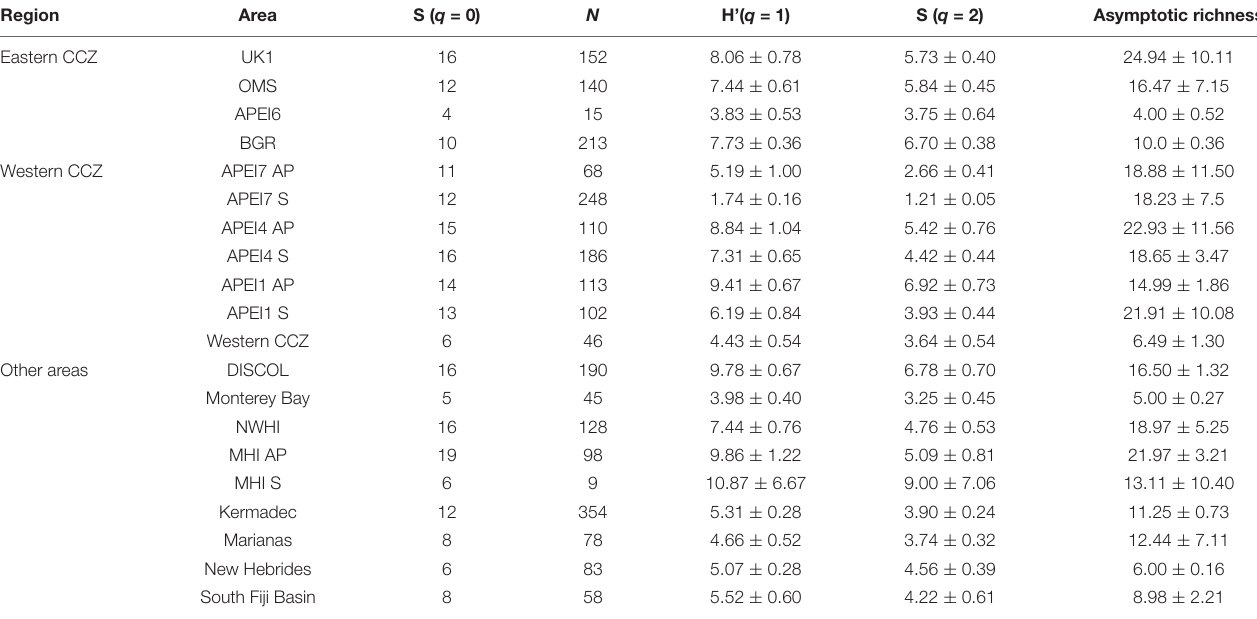
FIGURE 6 | MDS analysis of scavenger communities (MaxN data) across the Pacific. CCZ deployments are in orange, Hawaii locations in blue, DISCOL in light green, the western Pacific locations in dark green, and central California in red. Seamount deployments from the CCZ are circled. Letters above symbols represent significantly similar deployments ( p < 0.05; SIMPROF). TABLE 3 | Diversity measures (with standard errors) from baited camera deployments in the abyssal Pacific ordered from east to west in the CCZ followed by other areas of the Pacific.